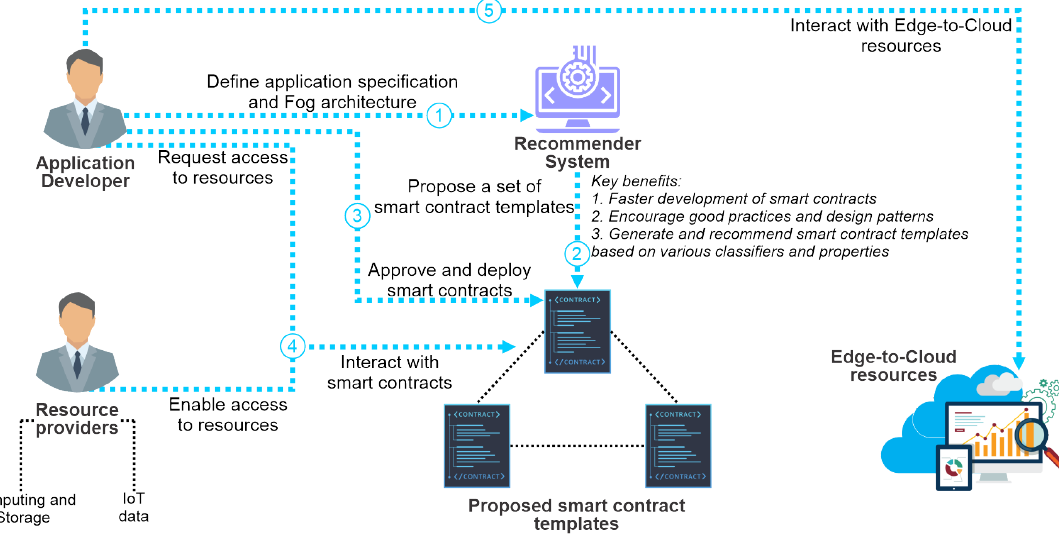
Figure 1. Outline of the baseline